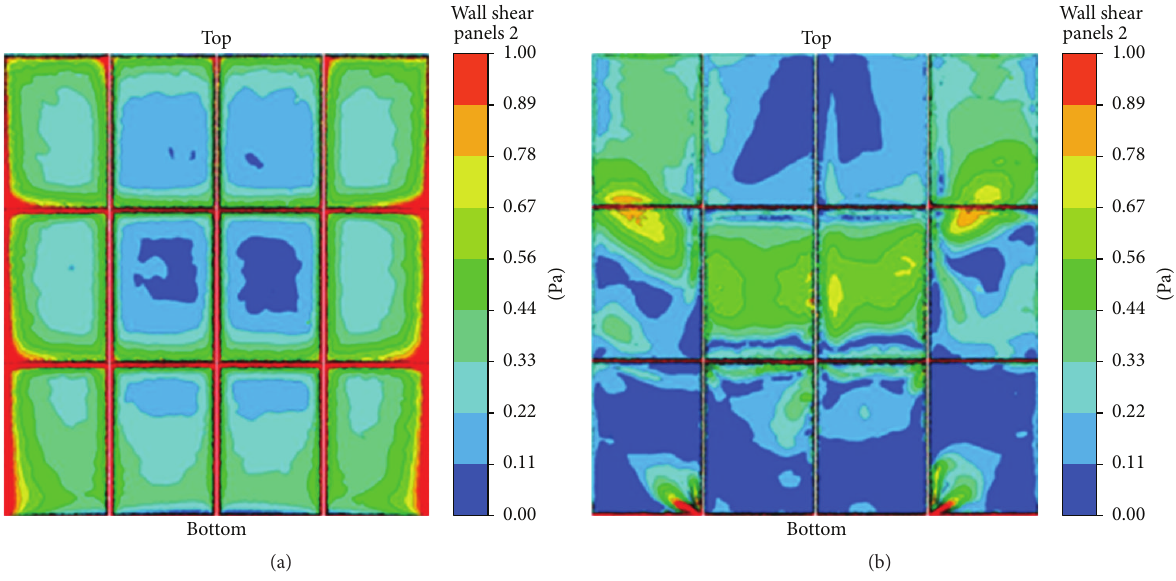
Figure 18: (a) Wall shear stress (N/m 2 ) contours at conventional panels: (a) upwind side and (b) downwind side.